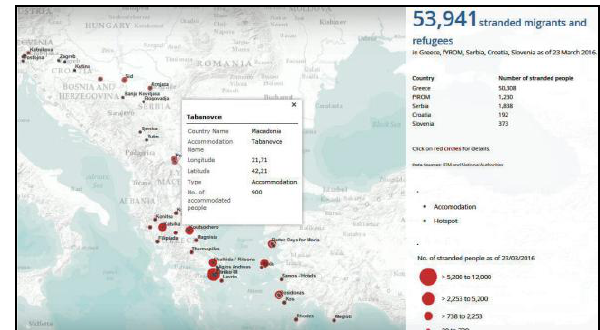
Figure 1: Interactive map monitoring of stranded migrants as of 23 March 2016 published by IOM platform for monitoring and analysis (IOM 2016).